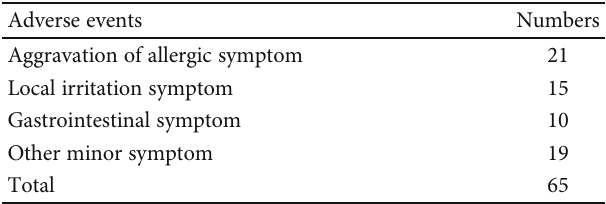
Table 3: Adverse events during